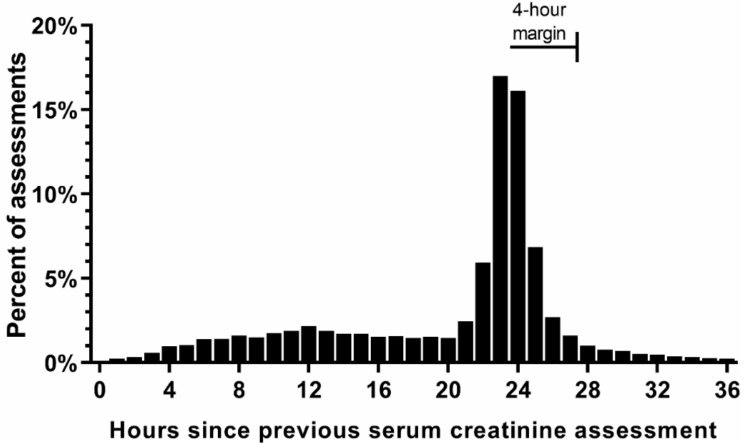
Figure 5. Histogram of hours between two serial serum creatinine assessments . The x-axis dis- plays the number of hours since the last serum creatinine (SCr) assessment rounded down to the nearest hour. The bar at “0” represents a time of 1 to 59 min since the last SCr assessment. For example, if SCr was measured at 04:00 a.m. on hospital day 1 and 04:30 a.m. on hospital day 2, the delta time between those assessments would be 24.5 h, which would be displayed on the bar at “24” on this figure. Of the 546,644 non-index SCr assessments that had a calculated time since last assessment, 87.5% were collected less than 37 h since the previous assessment. Data for 68,274 (12.5%) assessments that were collected more than 37 h since the previous assessment are not shown on this